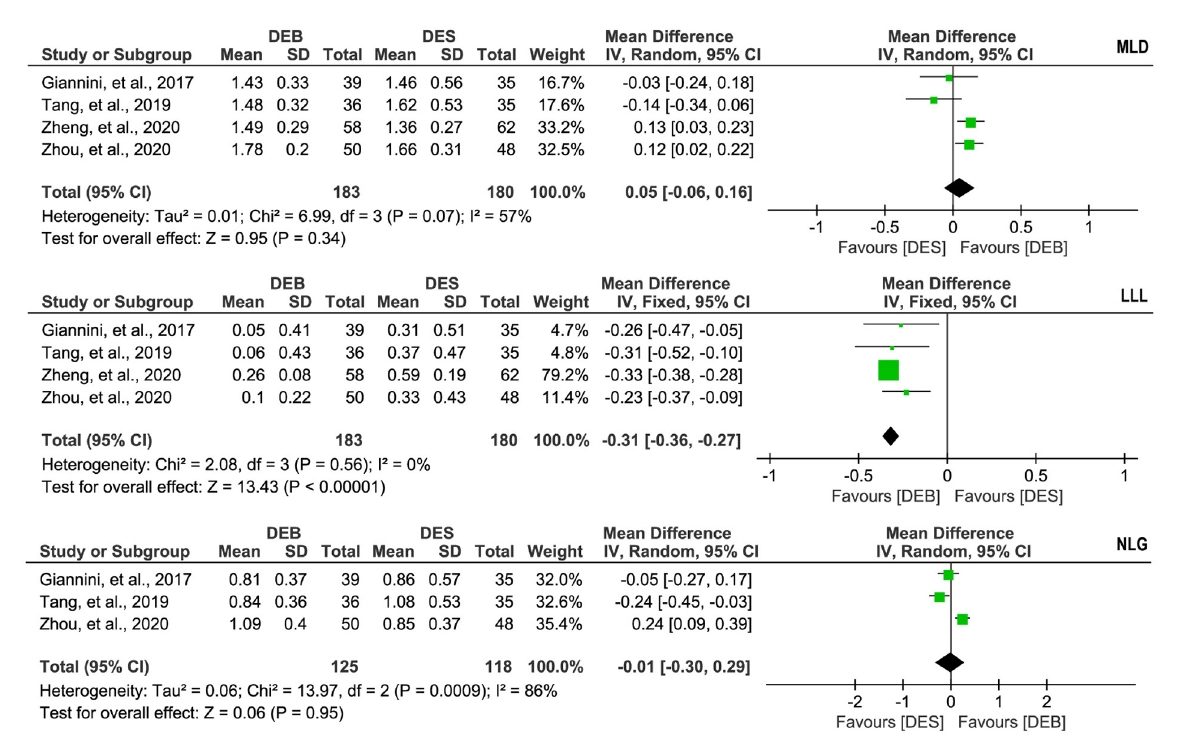
FIGURE5 Meta-analysis of MLD, LLL, and NLG. The black diamond represents the pooled result. If the black diamonds are completely to the left of the null line (“0”), it means that DEB is better than DES in terms of MLD, LLL, and NLG; if the black diamonds are completely to the right of the null line (“0”), it means that DEB is inferior to DES in terms of all outcomes; and if the black diamonds crossed through the null line (“0”), it means that DEB is comparable to DES in terms of all outcomes. MLD, minimal lumen diameter; LLL, late lumen loss; NLG, net lumen gain; DCB, drug-eluting balloon; DES, drug-eluting stent; IV, inverse variance; SD, standard